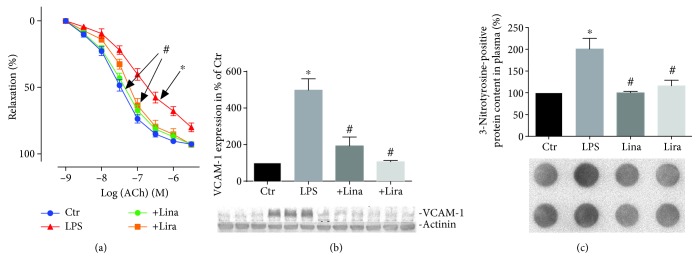
Antioxidant, anti-inflammatory, and vasculoprotective effects by the DPP-4 inhibitor or GLP-1 analog therapy in septic rats. (a) Endothelium-dependent (ACh) relaxation was determined by isometric tension studies in rat aortic ring segments. (b) Aortic expression of inflammatory protein VCAM-1 was assessed by Western blotting analysis and specific antibodies. (c) Levels of 3-NT-positive proteins in plasma were assessed by dot blot analysis and specific antibodies. Representative blots are shown below the densitometric quantification. The data are mean ± SEM from 4-8 (a–c) rats/group. ∗p < 0.05 vs. the control and #p < 0.05 vs. LPS. Adopted from Steven et al. [246] (with permission from Springer-Verlag Berlin Heidelberg. Copyright © 2015, Springer).